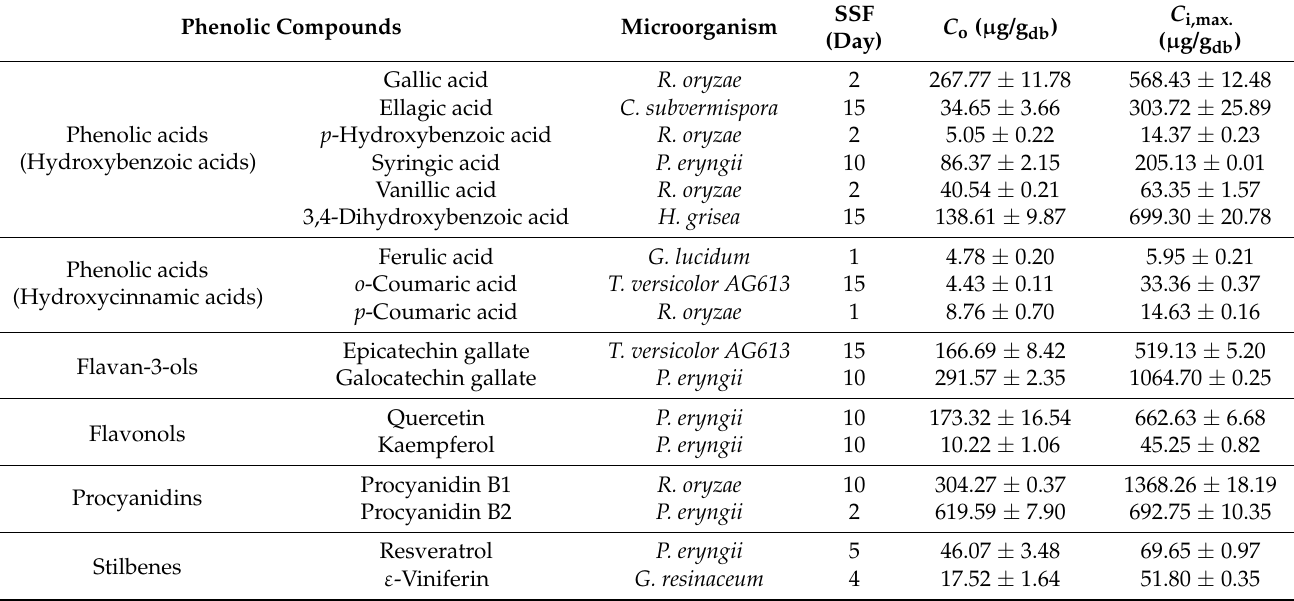
Table 2. Content of individual phenolic compounds in GP extract obtained before SSF (at ‘0’ day, C o ) and after SSF (max. content of phenolic compounds in GP extract regardless of duration SSF and used microorganism, C i, max.